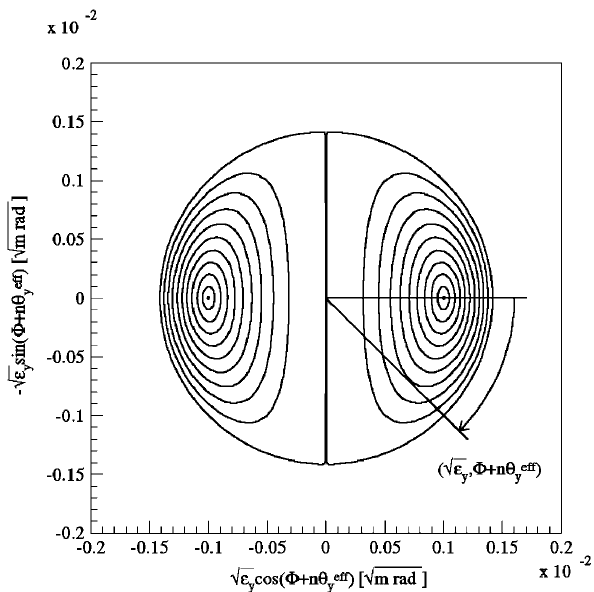
(cid:8) Q (cid:2) n x y